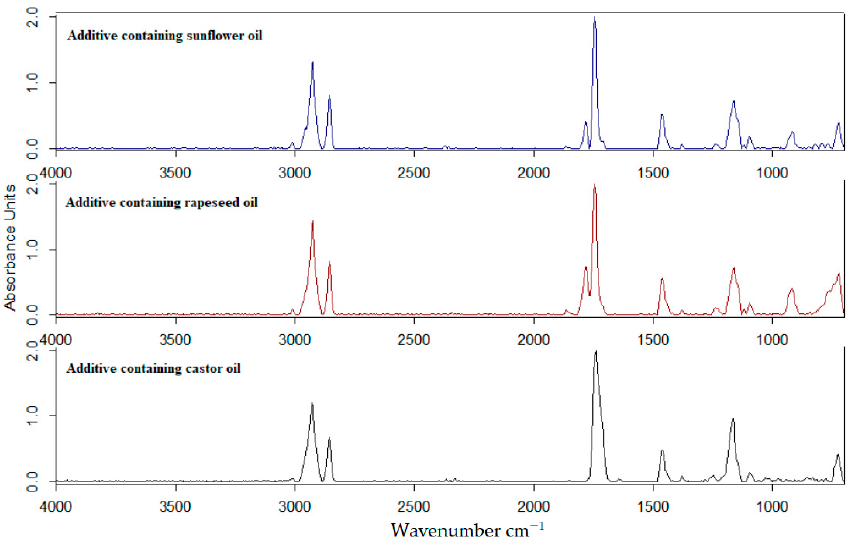
Figure 2. FT-IR spectra of vegetable oil-based additives in the wavenumber range 4000–600 cm − 1 .